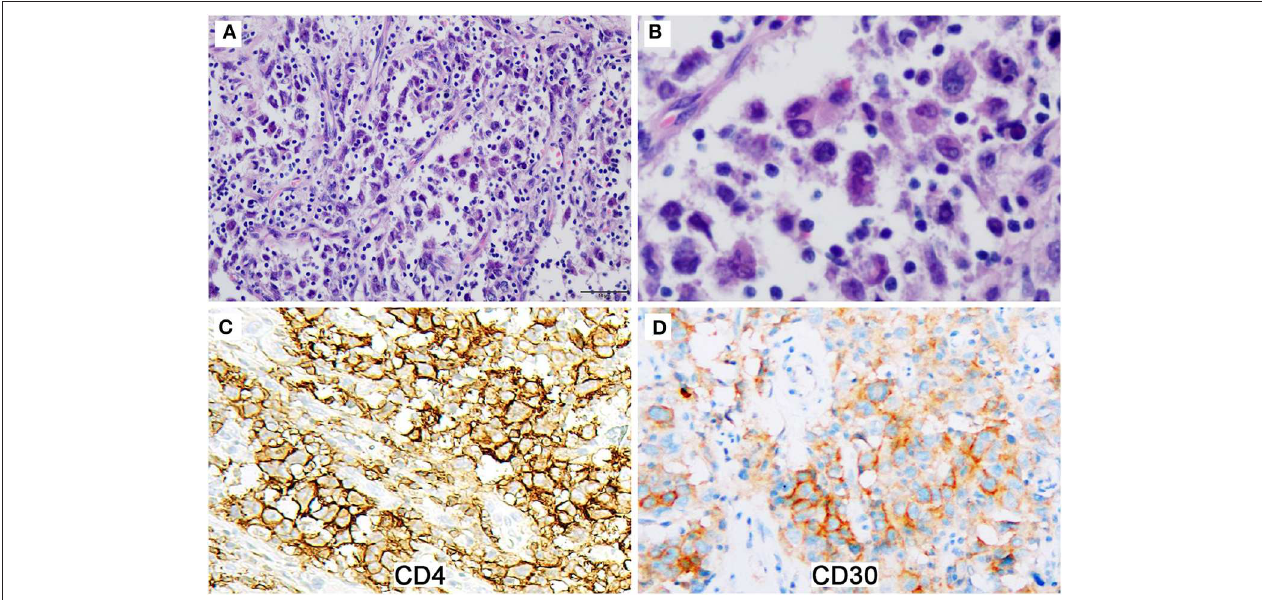
FIGURE 1 | The initial excisional specimen shows epithelioid tumor cells with co-expression of CD4 and CD30. (A) Epithelioid tumor cells arrange in nested and alveolar patterns with small lymphocytes scattered through the lesion (Magnification: 200 × ). (B) The tumor cells are large to pleomorphic with slightly irregular nuclei and abundant eosinophilic cytoplasm (Magnification: 400 × ). (C,D) The tumor cells are strongly positive for CD4 (C) and moderately positive for CD30 (D) (Magnification: 400 ×